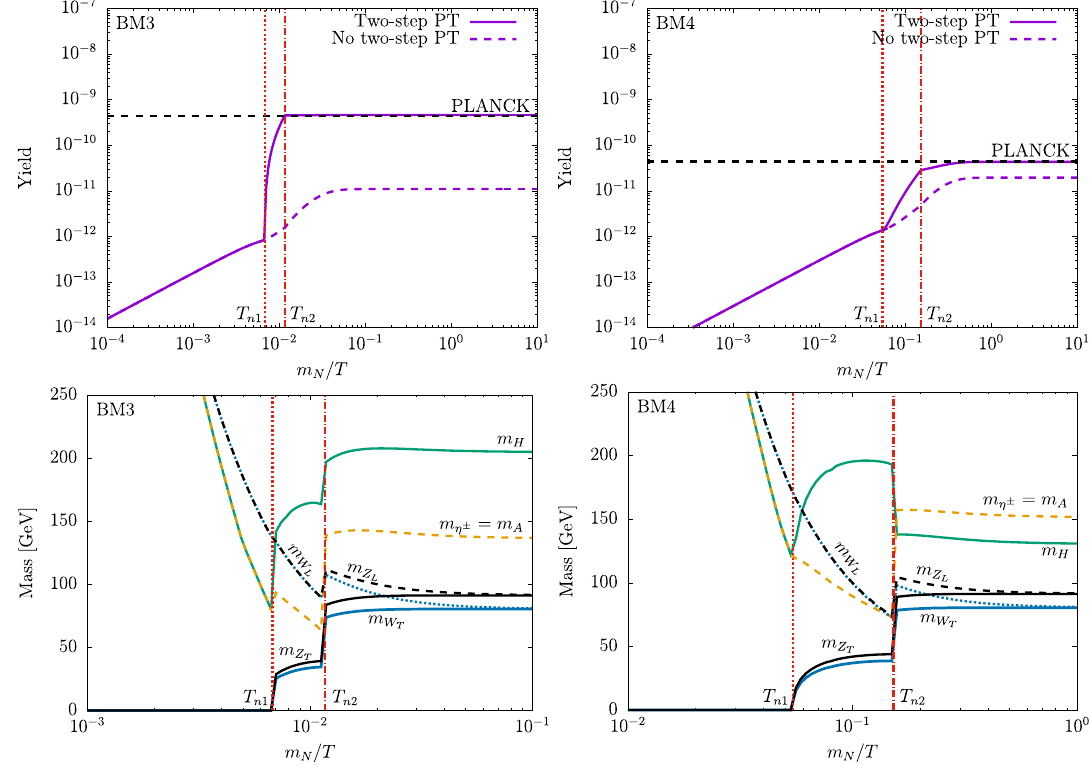
Figure 10 . Example solutions for the Boltzmann equation with the two-step PTs (top) and the masses of the inert scalars and gauge bosons with thermal effects (bottom). The left and right panels correspond to BM3 and BM4, respectively. The dark matter mass and the Yukawa coupling are fixed at ( m N , | Y | ) = (1 GeV , 2 . 1 × 10 − 12 ) for the left panels and (10 GeV , 2 . 8 × 10 − 12 ) for the right panels.